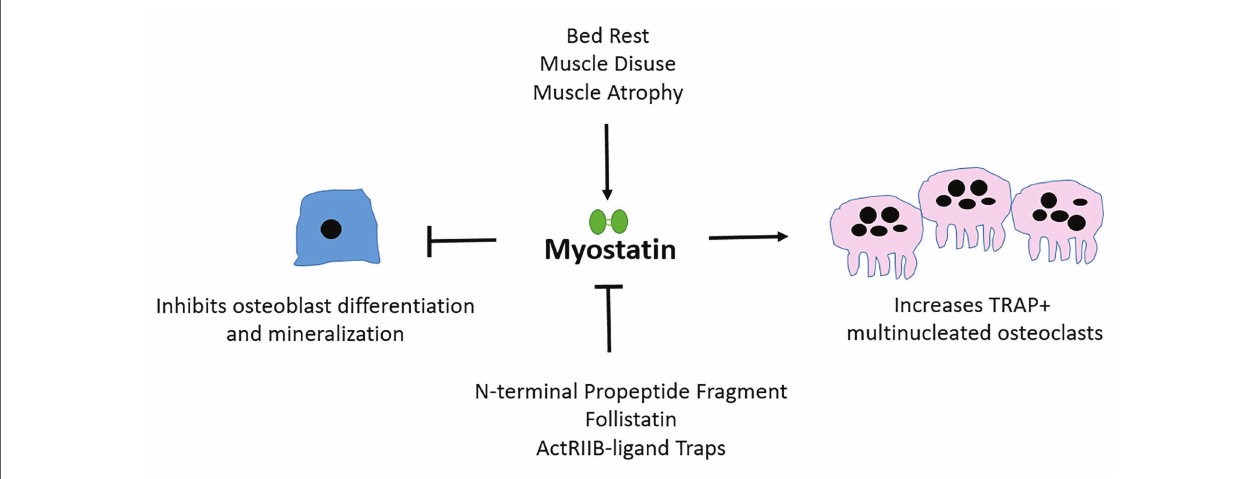
FIGURE 2 | Myostatin affects osteoblast, osteoclast, and osteocyte differentiation and cellular output. Myostatin is secreted by muscle and is upregulated during periods of atrophy or disuse. Myostatin inhibits osteoblast (bone-forming cells) differentiation and activates osteoclast (bone-resorbing) maturation. Follistatin and pharmacological agents that mimic ActRIIB, the receptor through which myostatin signals are examples of natural and artificial inhibitors of